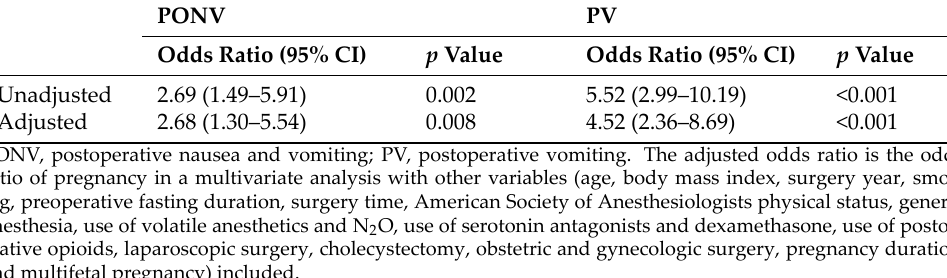
Table 4. Odds ratio of preoperative nausea and vomiting for developing PONV and PV in pregnant women who underwent nondelivery surgery. PONV